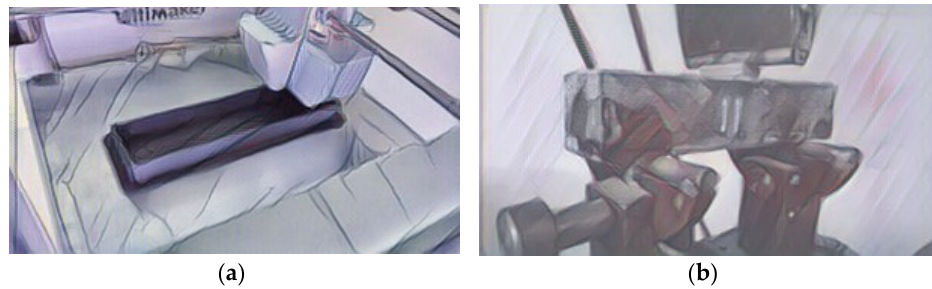
Figure 6. 3D printed beam formwork ( a ); flexural strength test of an element with 3D printed formwork ( b ). Images created by A. Skoratko (inspired by [54]).